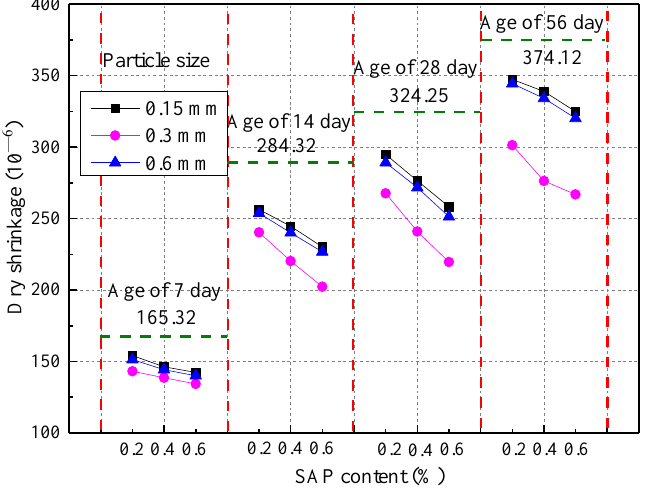
Figure 11. Dry shrinkage of SAP concrete at different ages.